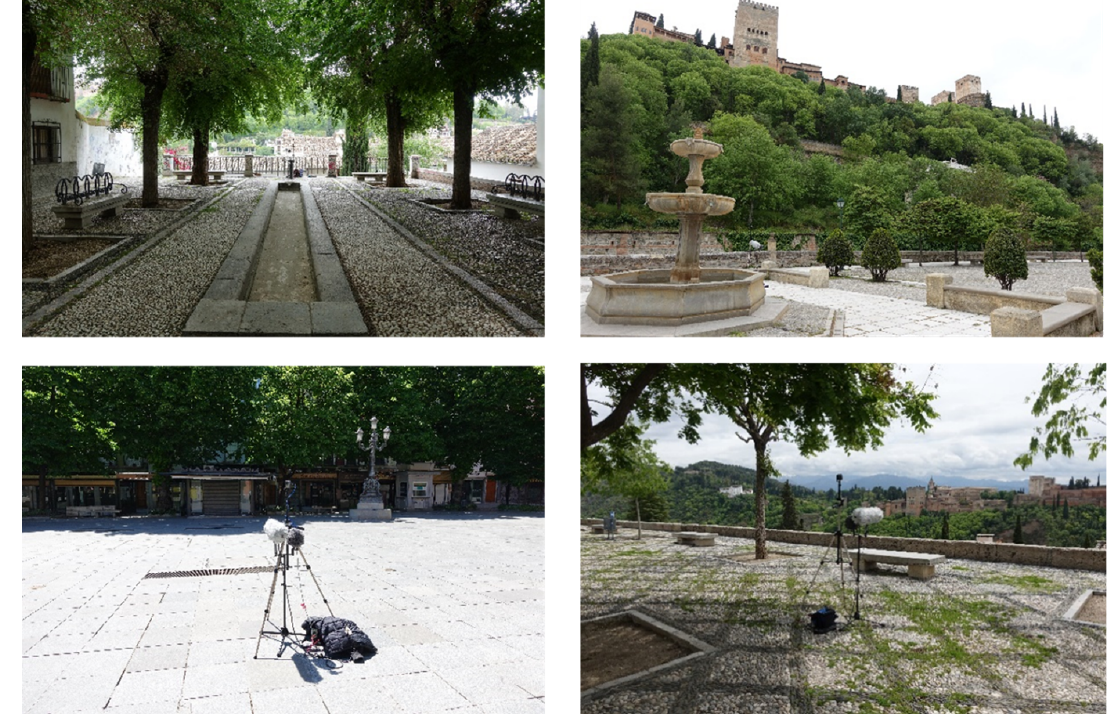
Figure 2: From left to right and from top to bottom Placeta de Carvajales (CAR), Paseo de los Tristes (PLT), Plaza de Bib-Rambla (BIB) and Plaza de San Nicolás (SNC). Own resource